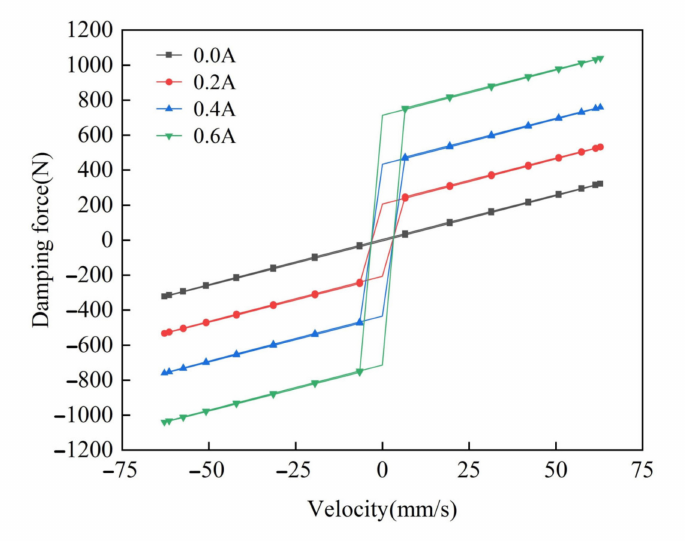
Figure 12. Force velocity curves under different current simulation